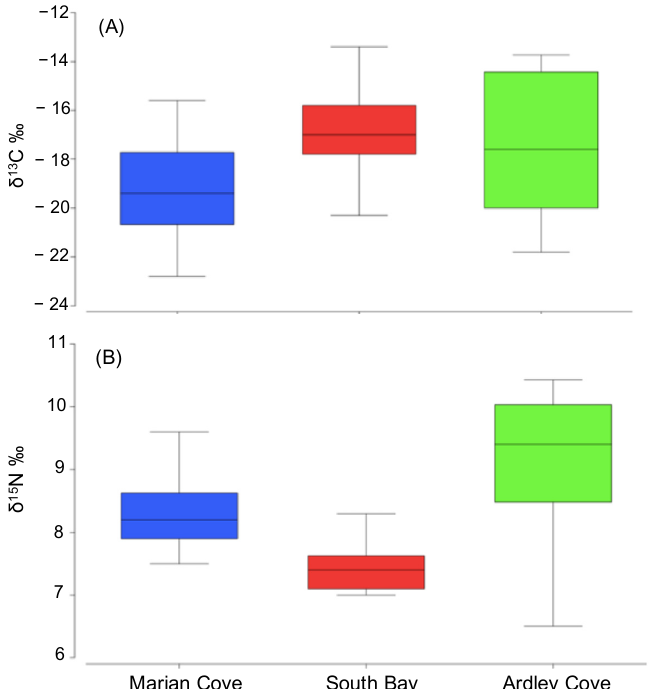
Figure 2. Box-whisker plots showing variation in O. validus – δ 13 C ( A ) and δ 15 N ( B ) values among regions.